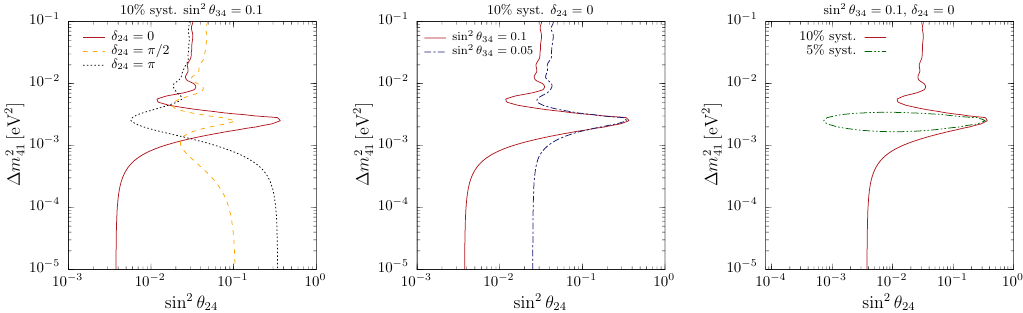
Figure 4 . Rejection power for the three-family hypothesis, as a function of the assumed true values of (cid:1) m 2 and sin 2 (cid:18) 24 . The true value of (cid:18) 34 has been set to a non-zero value in all cases, as 41 indicated in the labels, while (cid:18) 14 = 0 for simplicity. The contours indicate the sets of true values ( (cid:18) 24 , (cid:1) m 2 ) for which the three-family hypothesis would be successfully rejected at 90% C.L.. In 41 other words, they indicate the fraction of parameter space where the SM hypothesis (namely, the point (cid:18) i 4 = 0) would be disfavored with a (cid:1) (cid:31) 2 > 2 : 71. Left panel: dependence of the results with the true value of (cid:14) 24 . Central panel: dependence of the results with the true value of sin 2 (cid:18) 34 . Right panel: dependence of the results with the assumed priors for the systematic uncertainties. with respect to di(cid:11)erent parameters: the true value of (cid:14) (left panel), the true value of (cid:18) 24